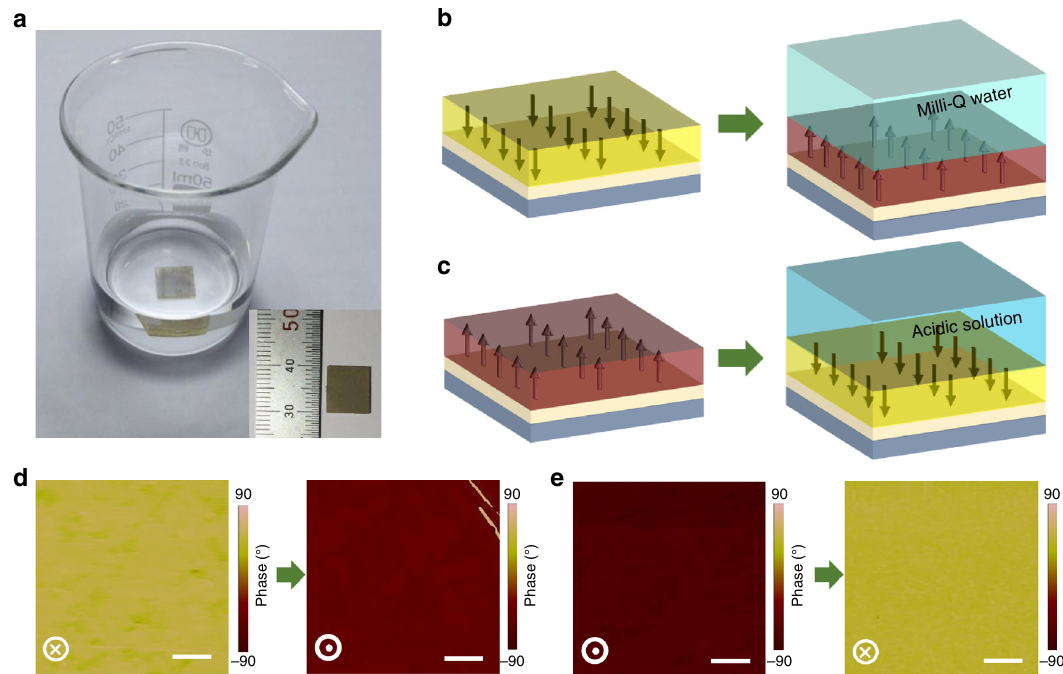
Fig. 2 Aqueous-solution-induced reversal of whole fi lm polarization. a Photograph of water treatment process and the corresponding sample size is 10 × 10 mm 2 (inset). The polarizations of the whole fi lms reversed to the upward ( b ) and downward ( c ) after exposing the fi lm to Milli-Q water and acidic solution, respectively. The corresponding PFM images showing the polarization switching from downward/upward to upward/downward after Milli-Q water ( d ) and acidic-solution ( e ) treatments. Scale bar, 2 μ m ( d , e